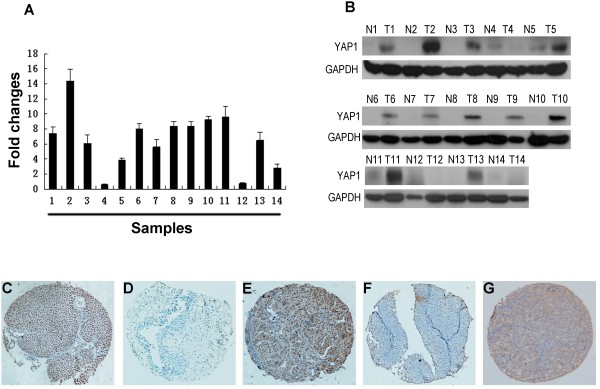
The expression of YAP 1 in UCB and normal bladder tissues. (A) Up-regulated expression of YAP 1 mRNA was examined by qRT-PCR in 12/14 UCB cases, when compared with paired normal bladder tissues. Expression levels were normalized for β-actin. Error bars, SD calculated from three parallel experiments. (B) Up-regulated expression of YAP 1 protein was detected by Western blotting in 11/14 UCB cases, when compared with paired normal bladder tissues. Expression levels were normalized with GAPDH. (C-F) The expression of YAP 1 in UCB and normal bladder tissues by IHC (100×). An UCB (case 39) tissue showed high expression of YAP 1, in which more than 90% of tumor cells were positively stained by YAP 1 in the nucleus (C), while its paired normal bladder urothelial mucosal tissue was negatively stained by YAP 1 (D). High expression of YAP 1 was observed in another UCB tissue (case 102), in which about 70% of tumor cells demonstrated a nuclear staining with a lesser cytoplasmic staining of YAP 1 (E). An UCB (case 78) was examined low expression of YAP 1, in which less than 5% of tumor cells showed nuclear staining of YAP 1 (F). An UCB (case 114) tissue showed high expression of YAP 1, in which more than 90% of tumor cells were positively stained by YAP 1 in the cytoplasm (G).